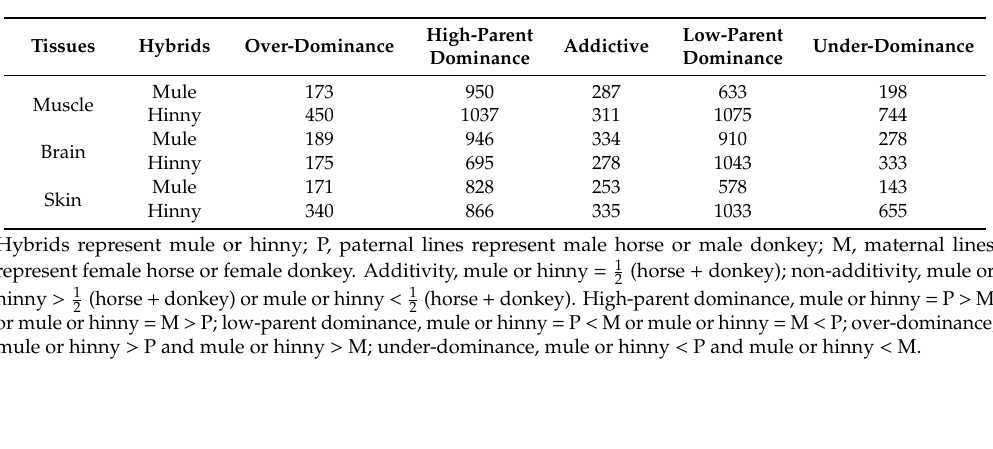
Table 4. Classification of genes via di ff erentially splicing events following the gene expression patterns.